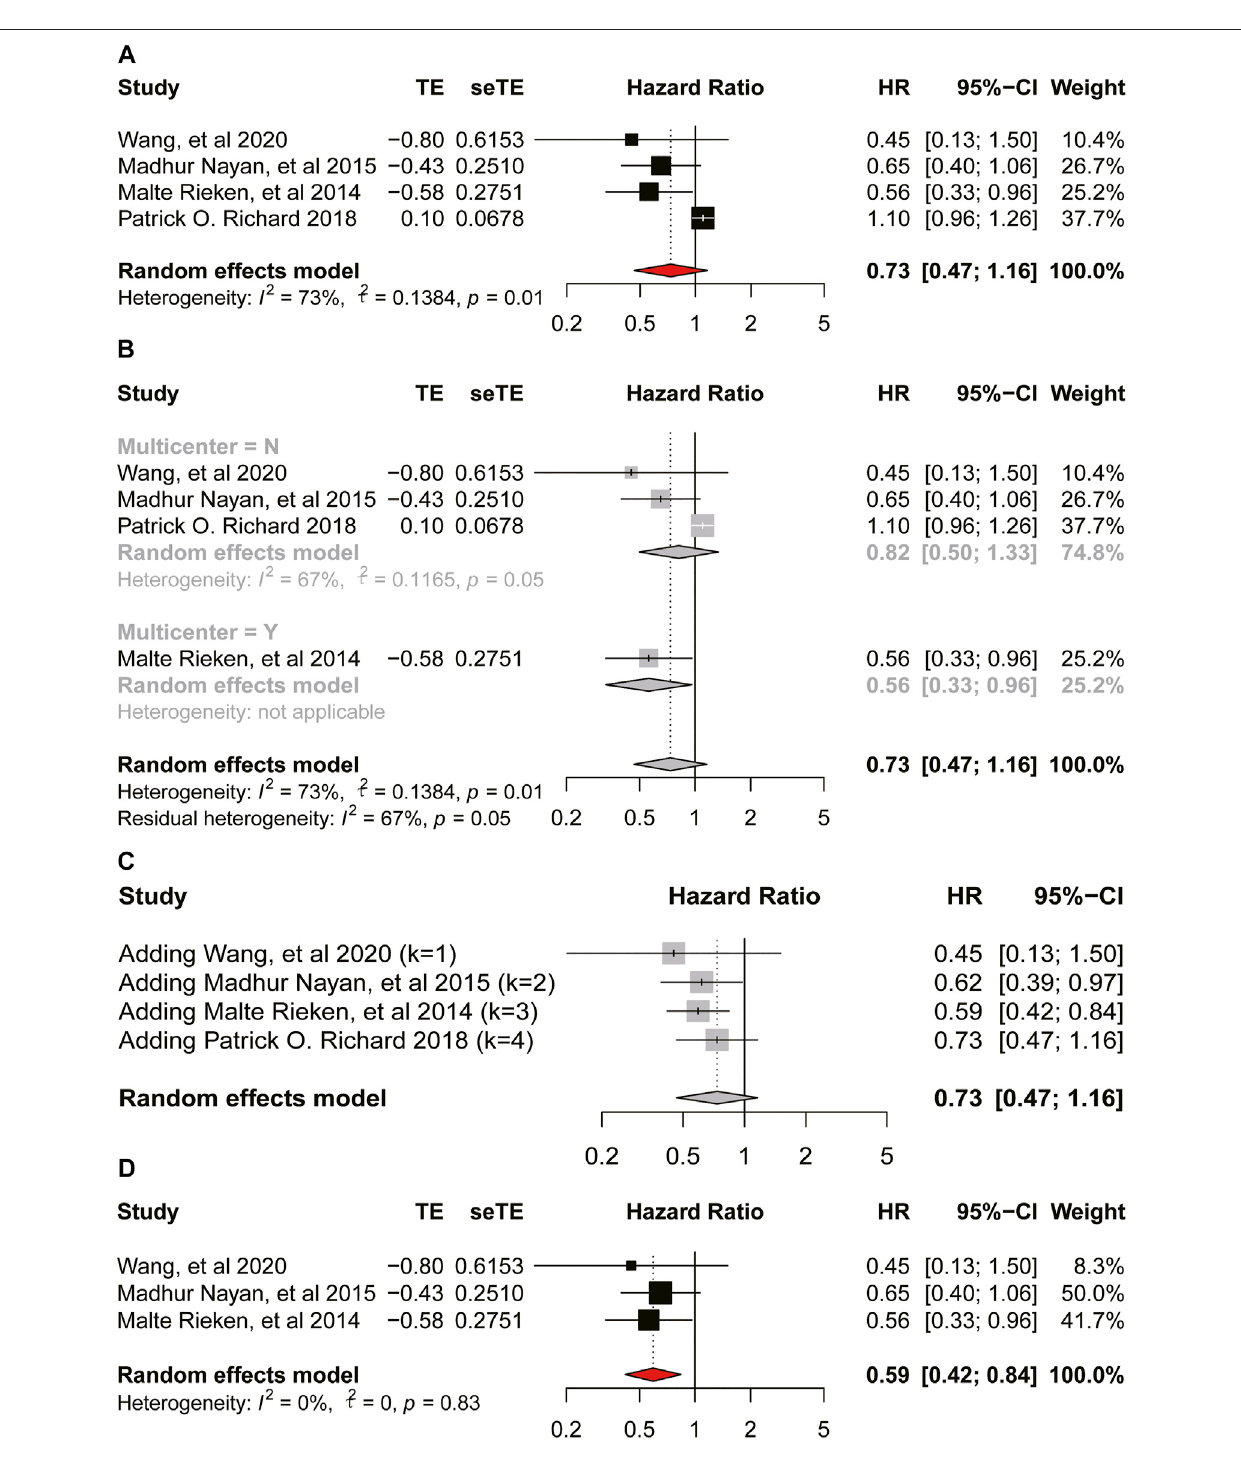
FIGURE 4 | Forest plot of hazard ratio for disease-speci fi c-survival (A) Association between use of metformin and DSS of bladder cancer. (B) Subgroup analysis based on whether it is multicenter. (C) Accumulation meta-analysis. (D) Association between use of metformin and DSS of bladder cancer after removing a study.